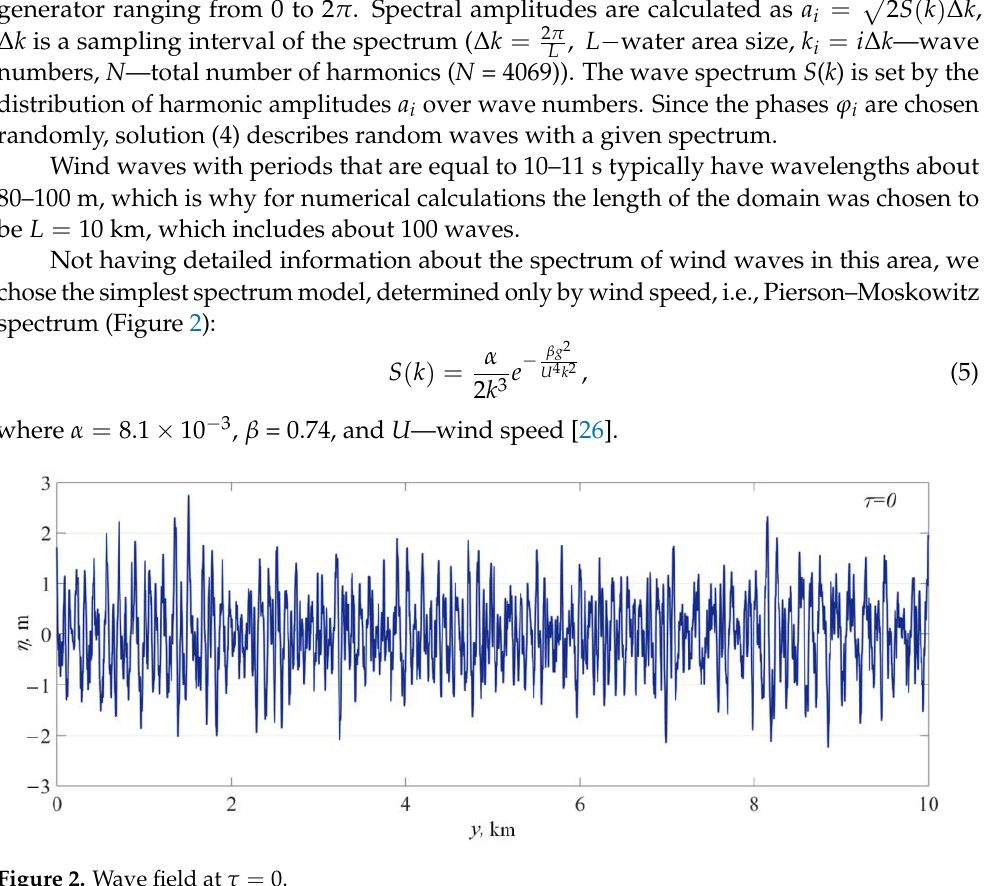
Figure 2. Wave field at 𝜏 = 0 .